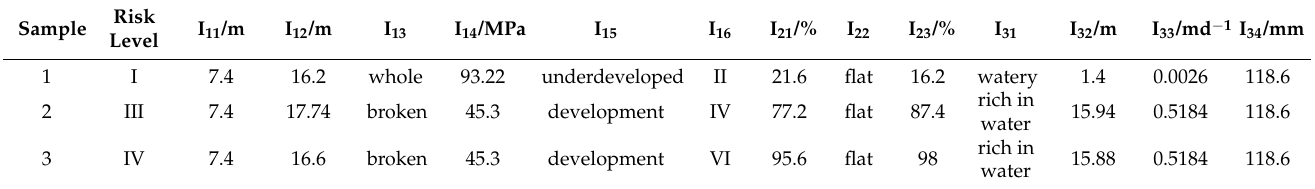
Table 8. Risk index data of water inrush in each tunnel section of Jingsha section of Qingdao Metro Line 4.